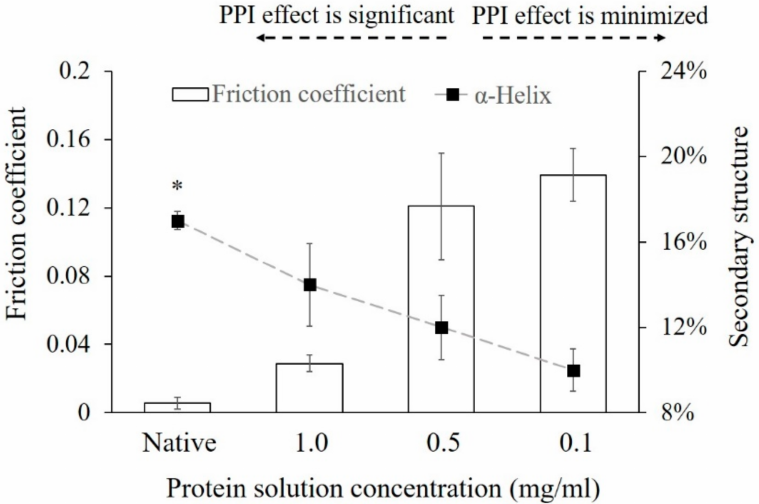
Figure 4. Comparison of friction coefficients exhibited on the surface at different protein concen- trations and the subsequent structural changes ( α -helix (%)). “Native” presents the native protein structure in solution and friction coefficient measured with no protein adsorbed on the glass surface. The error bars denote the mean ± SD for n = 3. * represents the significant difference in helix structure and friction coefficient with p <